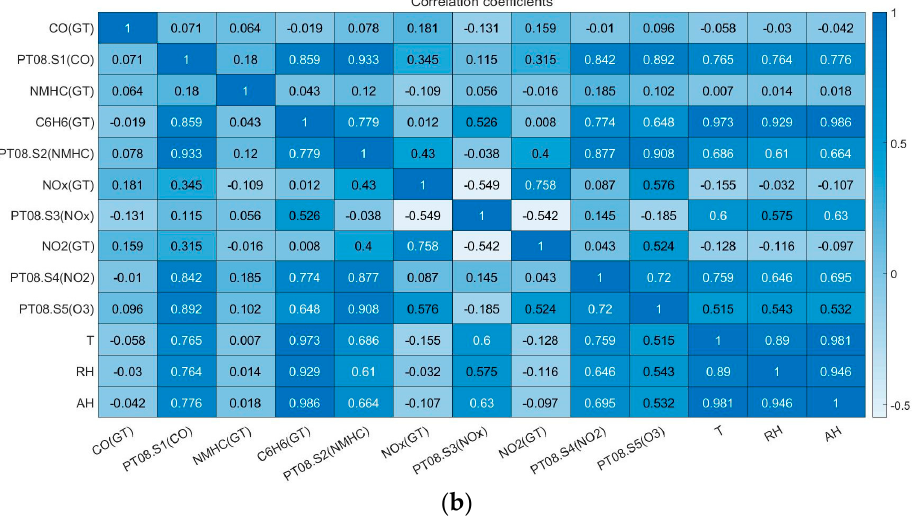
Figure 3. The matrix of correlation coefficients for air pollution indicators of ( a ) Beijing and ( b ) an Italy city.